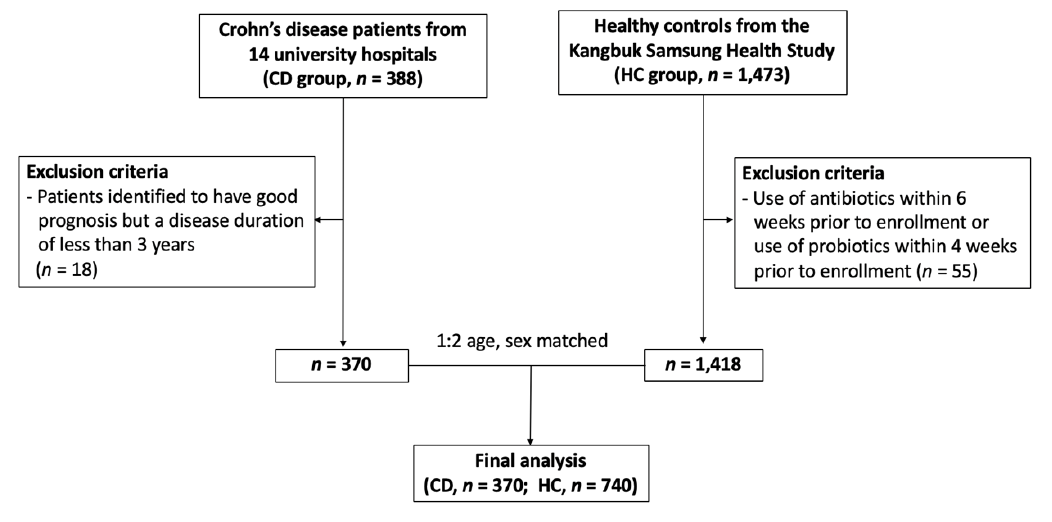
Figure 1. Enrollment of subjects.